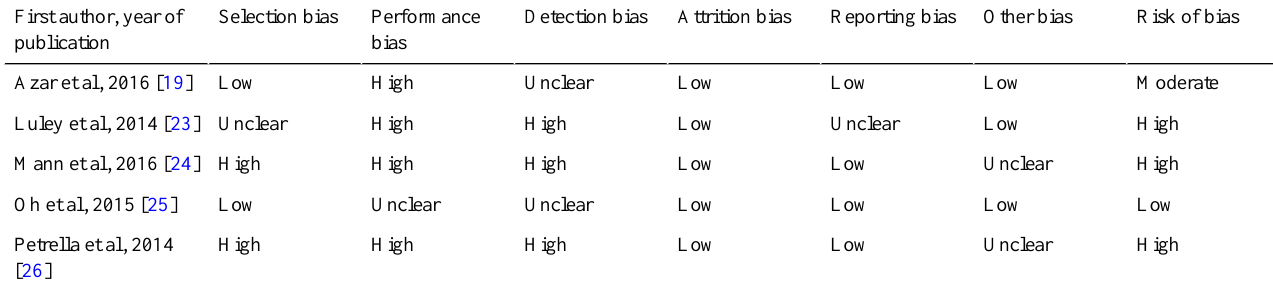
Table 3. Quality assessment of the included randomized controlled